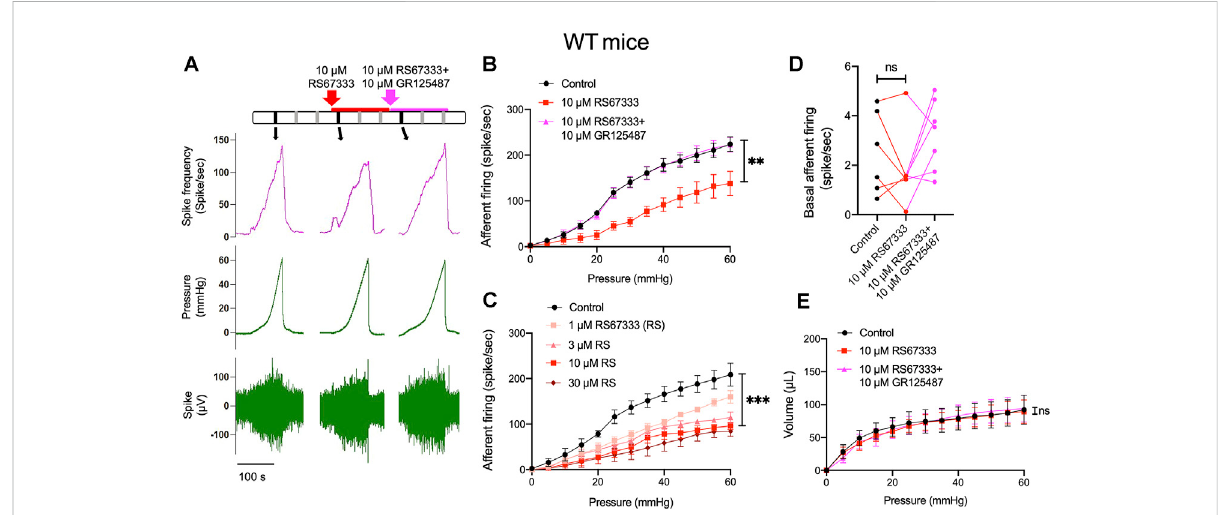
FIGURE 3 Activation of 5-HT 4 R inhibits mechanosensory activity of bladder afferent nerves. (A) Schematic of drug administration and original recordings froman exvivo pelvicnerverecordingpreparationshowingbladderafferent fi ringandintravesicalpressure.Eachvertical linerepresentsadistension and the original record of the black vertical lines presented in the below. (B) Relationship between bladder afferent fi ring and intravesical pressure showing a signi fi cant decrease in afferent fi ring in the presence of RS67333 (10 μ m) and reversal of the effect by GR125487. The averaged area underthecurve(AUC) ofControl(1,368±80.8), RS67333(762.3±130.8),R&G(1,376±77.38)werecompared usingone-way ANOVA. n =6 – 8mice foreachgroup.(**, p =0.002,RS67333vs.Control.) (C) EffectsofdifferentconcentrationsofRS67333(1,3,10and30 μ m)onthemechanosensitivity ofbladderafferentnerves.AUCanalysisusingone-wayANOVA:Control1,319±90.14;1 μ M925.5±53.10( p =0.0244vs.control);3 μ m768±79.09 ( p =0.0029vs.control);10 μ m607±112.7( p =0.0012vs.control);30 μ m498.1±143.9( p =0.0003vs.control). n =4miceforeachgroup. (D) Effect of RS67333 and R&G (10 μ m) on basal afferent fi ring (ns = not signi fi cant, one-way ANOVA, p > 0.05). (E) The relationship between intravesical pressure and volume (the compliance) during ramp bladder distension was unaffected by intravesical administration of RS67333 and R&G (10 μ m, ns = not signi fi cant, one-way ANOVA, p >